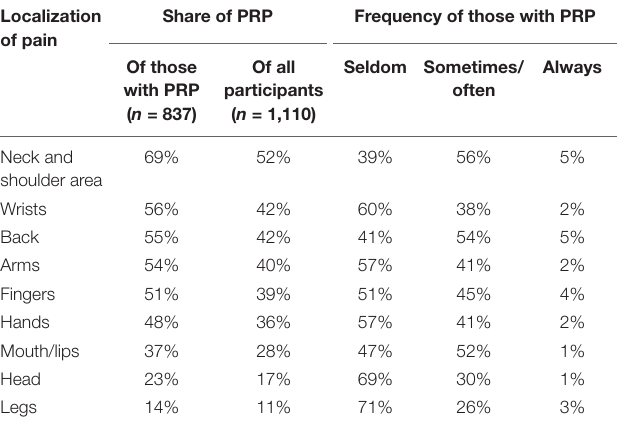
TABLE 5 | Localization and frequency of PRP.